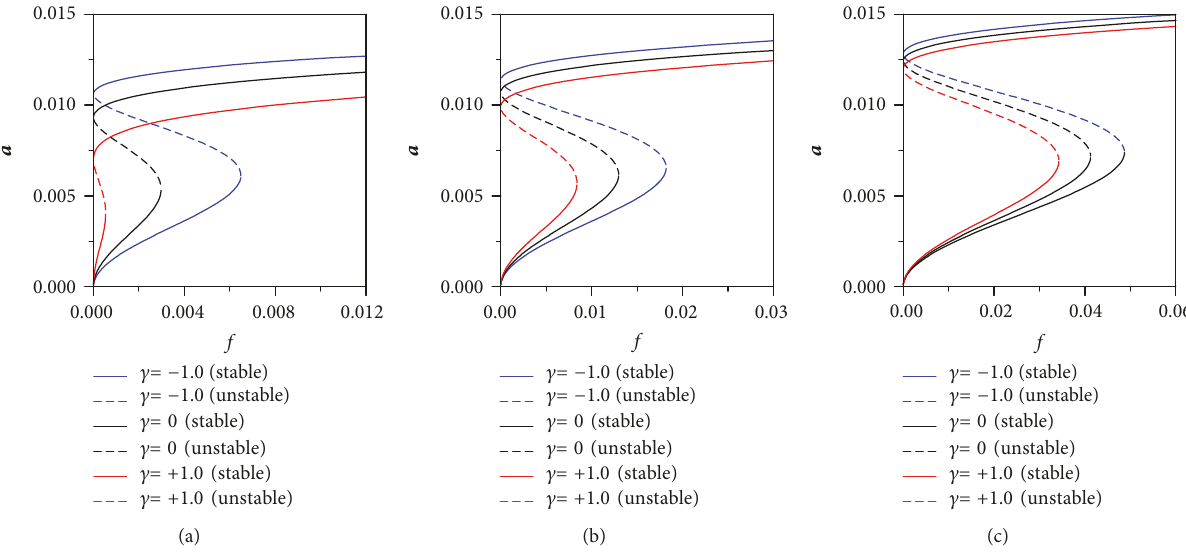
Figure 4: Excitation response curves of primary resonances (𝜎 = 2.0) : (a) hinged-hinged; (b) hinged-fixed; (c) fixed-fixed.